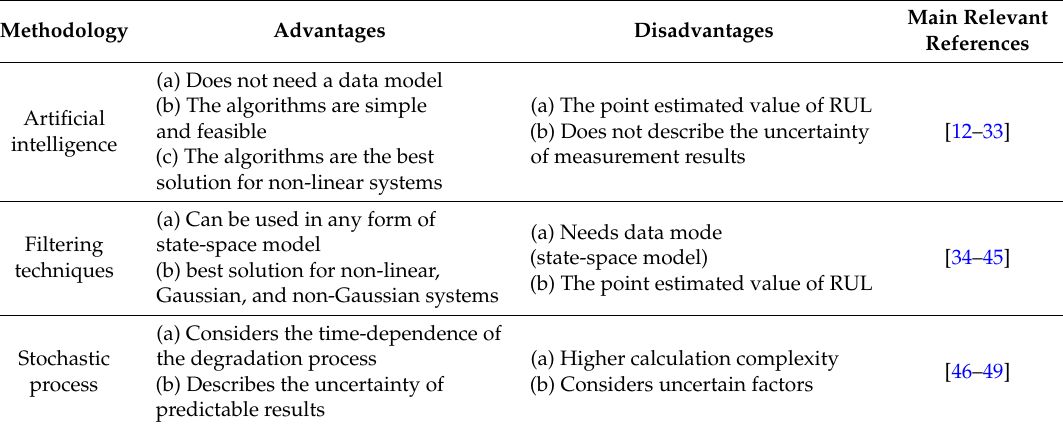
Table 1. Comparison of RUL prognostics of vehicle lithium-ion batteries using data-driven